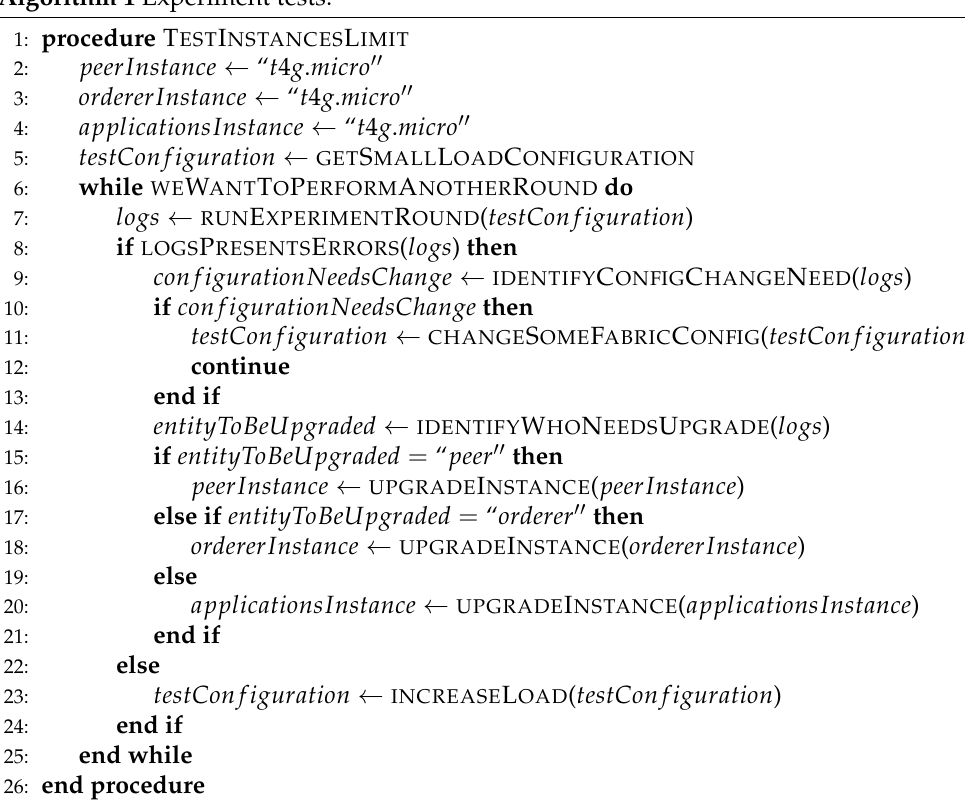
Algorithm 1 Experiment